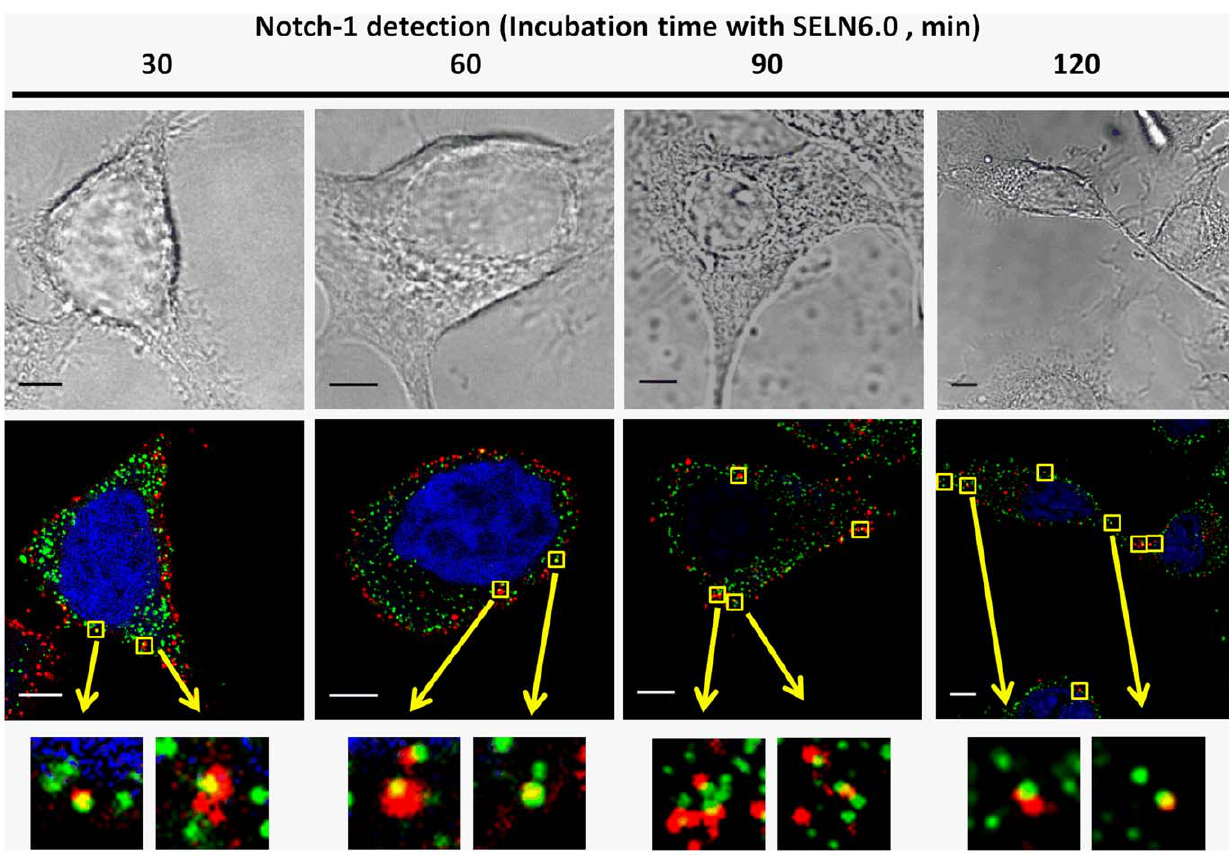
Figure 11. Co-localization of Fluorescent SELN6.0 with Notch-1 in SOJ6 cells. SOJ-6 cells were treated as in Fig. 10 and incubated (for the indicated times) with N - Rh-PE-loaded SELN 6.0 (1.6 nmol cholesterol/100 m l culture medium). Cells were fixed with PFA, permeabilized, saturated and nuclei labelled with Draq5. Cells were then incubated with antibodies to Notch-1 (extracellular domain) and further detected with Alexa Fluor 488- labelled secondary antibodies. Squares indicate co-localization (yellow) and arrows indicate enlarged area (inserts) where Notch-1 co-localizes with N - Rh-PE labelled SELN6.0 (Scale bar=5 m m).